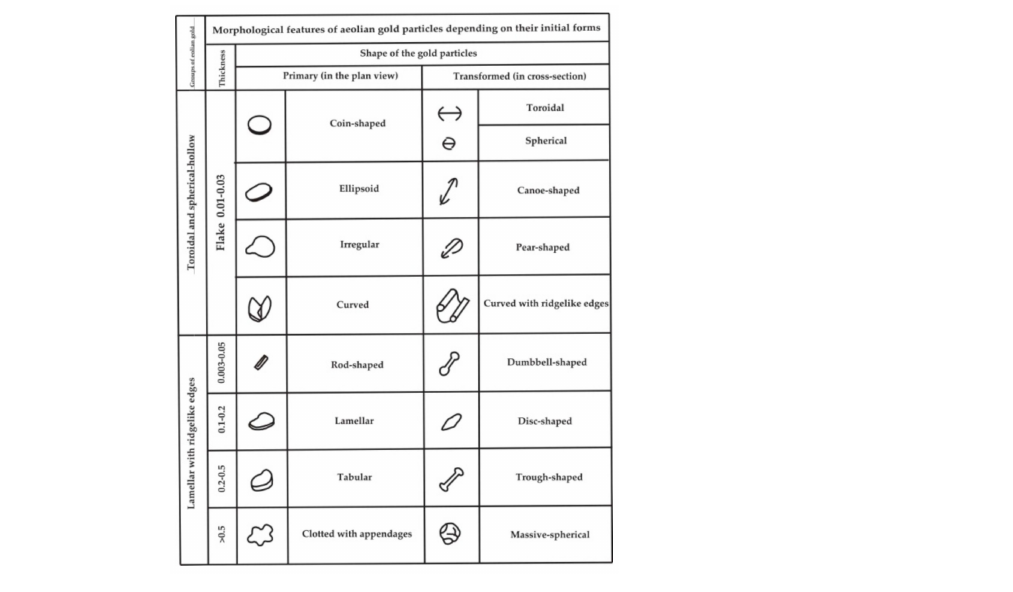
Figure 11. Morphological features of aeolian gold particles depending on their initial forms.